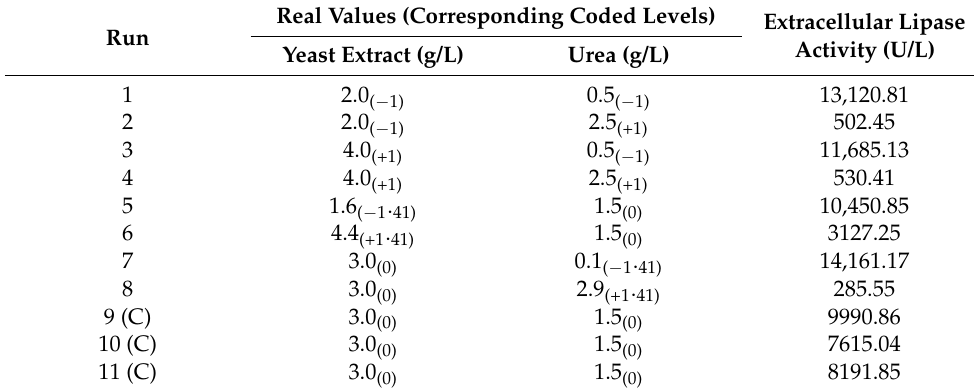
Table 1. Matrix of experimental runs for the central composite rotatable design for lipase production by Yarrowia lipolytica cultivated in Erlenmeyer flasks for 16 h in pomegranate-seed residue (PSR) supplemented with yeast extract and urea. Real Values (Corresponding Coded Levels) Extracellular Lipase Run